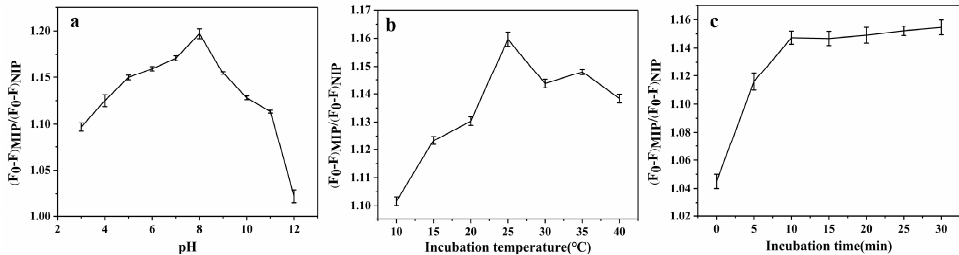
Figure 2. Effects of ( a ) pH value, ( b ) incubation temperature, and ( c ) incubation time on fluorescence quenching efficiency ( n = 3). Experimental conditions: V MIPs@BCDs/RCDs@SiO2 = 100 µ L, λ ex = 360 nm, quenching efficiency ( n = 3). Experimental conditions: V MIPs@BCDs/RCDs@SiO 2 = 100 μ L, λ ex = 360 nm, C P- C P-CTX-3C = 0.1 CTX-3C = 0.1 ng/mL.